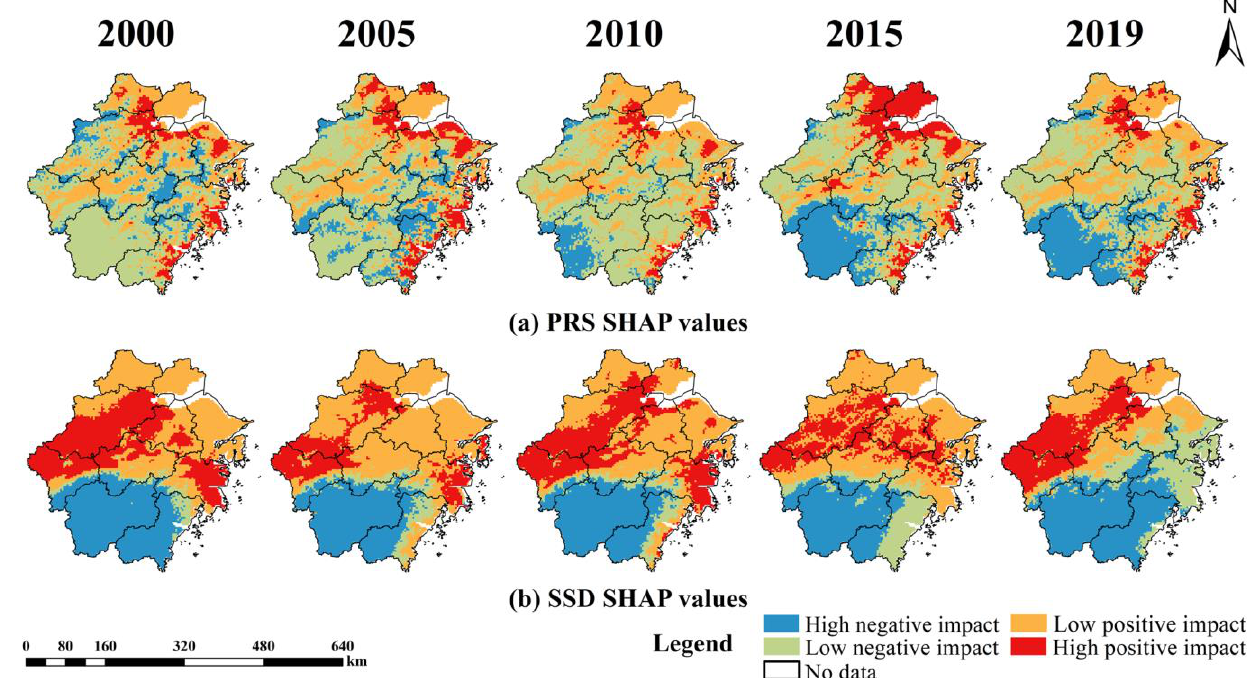
Figure 8. Spatiotemporal variations in SHAP values for meteorological factors.